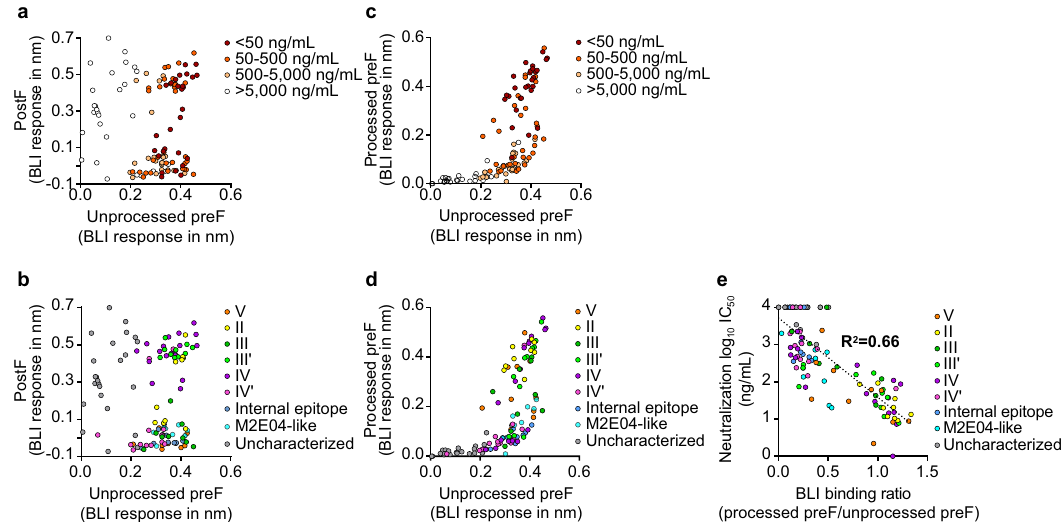
Fig. 5 Correlations among neutralization potency, antigenic sites, and binding-speci fi city to different hMPV F conformations. a , b BLI binding response of hMPV F-speci fi c mAbs to unprocessed hMPV PreF trimer and PostF trimer. Each dot represents an isolated hMPV F-speci fi c antibody, colored by neutralization potency ( a ) or mapped antigenic site ( b ). c , d BLI binding response of hMPV F-speci fi c mAbs to unprocessed hMPV PreF and processed stabilized hMPV PreF (115BV) antigens. Each dot represents an isolated hMPV F-speci fi c antibody, colored by neutralization potency ( c ) or mapped antigenic site ( d ). e Correlations between neutralization potency (after Log 10 transformation) and the ratio of processed PreF/unprocessed PreF BLI binding. The dashed line and R-square number indicate the linear regression. Each dot represents an isolated hMPV F-speci fi c antibody, colored by the mapped antigenic site. For each antibody, the higher neutralization potency between hMPV A and B was chosen to plot. Source data are provided as a Source Data fi